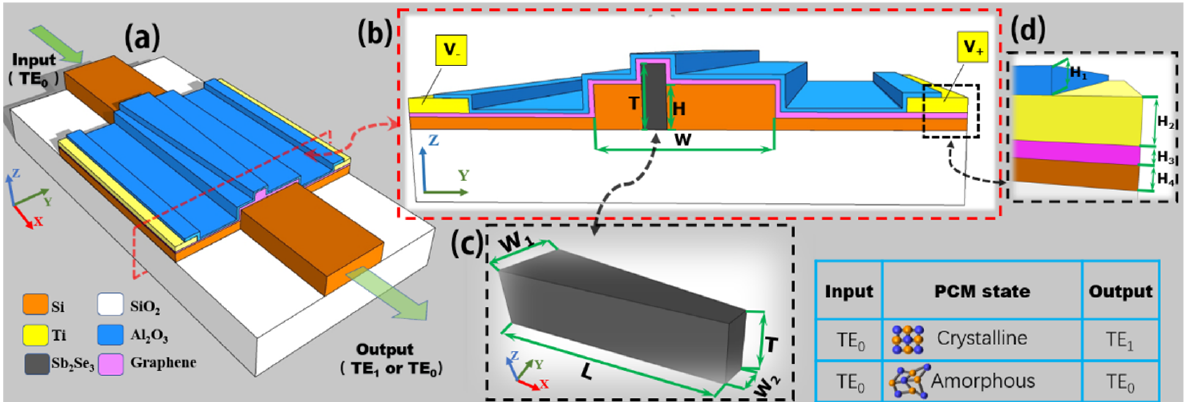
Figure 1. ( a ) Three-dimensional schematic of the proposed compact reconfigurable silicon waveguide mode converter. ( b ) Cross-sectional view of the mode conversion region of the proposed device. ( c ) Side view of the embedded PCM layer. ( d ) Enlarged view of the metal contacting components including the different material layers. The table shows the main device function. For input TE 0 mode, the output can be switched between either TE 1 or TE 0 mode depending on the state of the PCM. The material and structural parameters of the proposed device are as labelled in the figures.